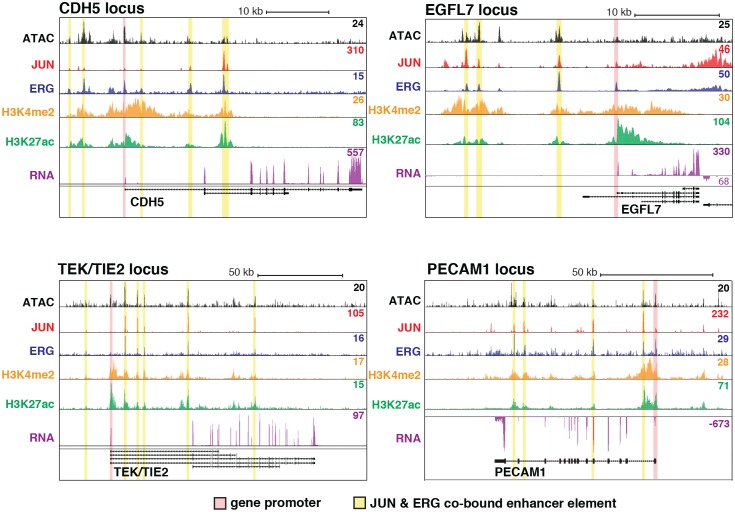
JUN and ERG co-occupy loci near EC-specific genes.ATAC-seq, binding for JUN and ERG, histone modifications H3K4me2 and H3K27ac, and RNA abundance are shown at the genetic loci for CDH5, EGFL7, TEK/TIE2, and PECAM1. Promoters are highlighted in pink, and JUN/ERG co-bound enhancers are highlighted in yellow.